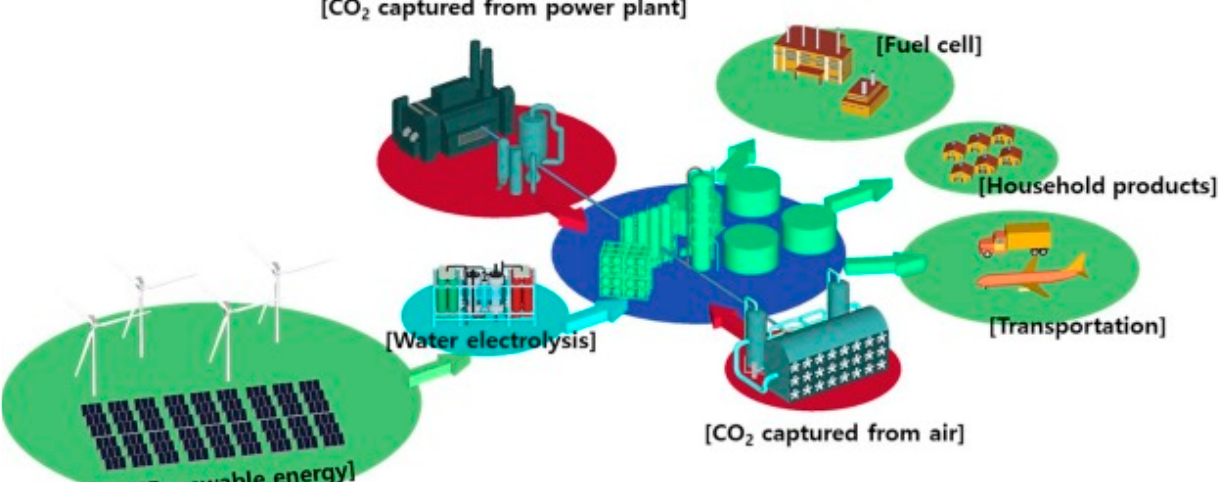
Figure 10. Overview of the Power-to-Liquid (P2L) scheme for renewable green methanol synthesis using CO 2 hydrogenation technology with green H 2 [104].